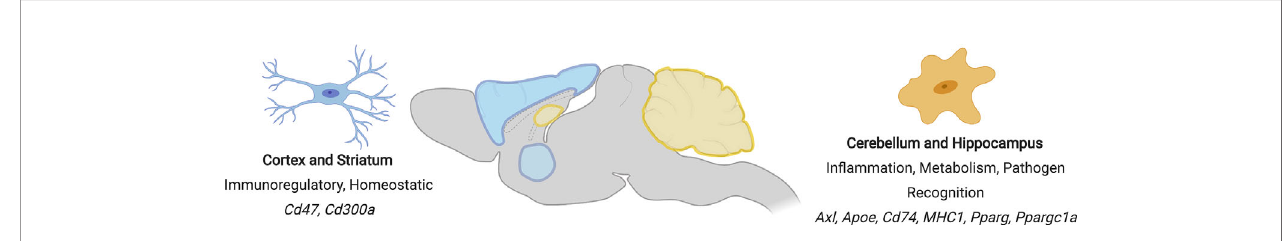
FIGURE 3 | Regional differences in microglial phenotypes in the mouse brain. Regions showing similar microglial phenotypes are similarly coloured (cortex and striatum = blue, cerebellum and hippocampus = yellow). Phenotypic characteristics and signature genes for each region are